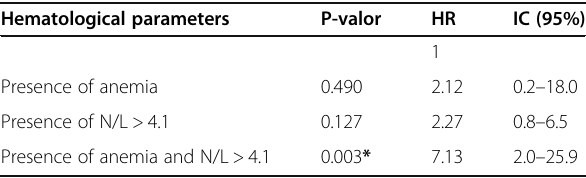
Table 2 Multivariate analysis of hematological parameters anemia and N/L > 4.1 with tumor recurrence-regrowth Hematological